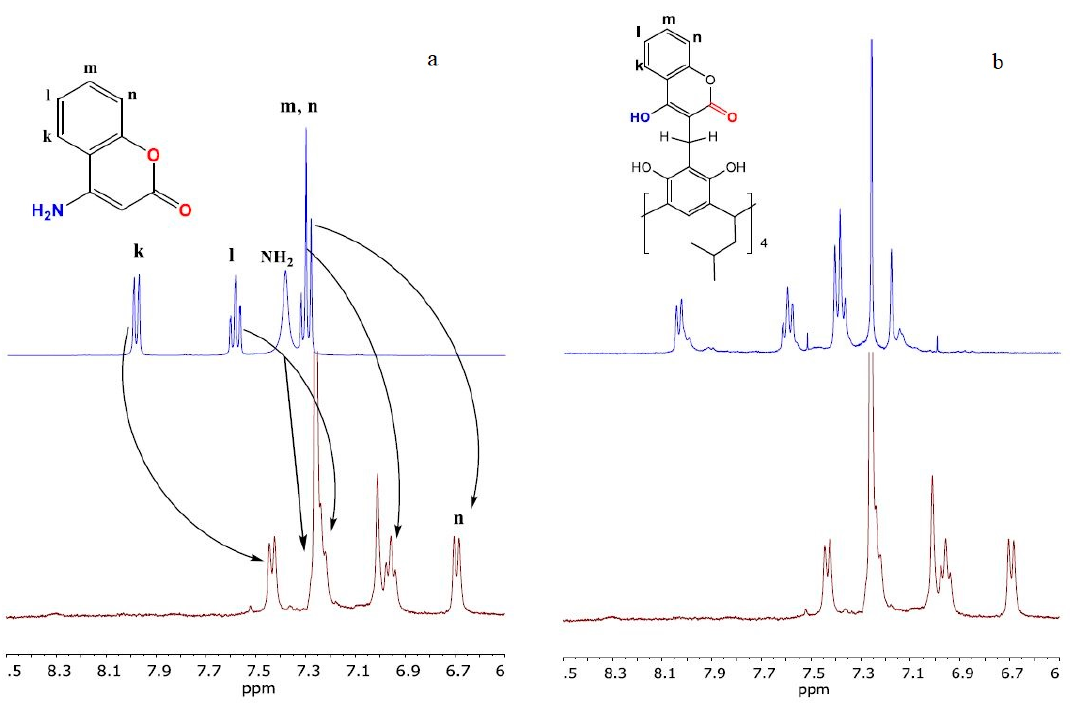
Figure 3. ( a ) A comparison of fragments of the 1 H NMR (400 MHz) 4-aminocoumarin spectra (top, blue) and derivative 3 (bottom, brown) in CDCl 3 at 298 K.; ( b ) A comparison of fragments of the 1 H NMR (400 MHz) hydroxycoumarin derivative of resorcin[4]arene spectra (top, blue) and derivative 3 (bottom, brown) in CDCl 3 at 298 K.